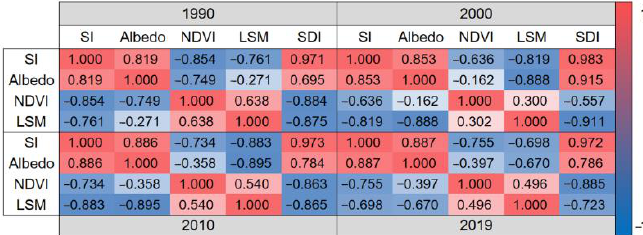
Figure 3. Correlations between pairs of the four selected indicators and their correlations with the SDI in different study years. SI: salinization index; NDVI: normalised difference vegetation index; LSM: land surface soil moisture index; SDI: salinized land degradation index. The blue and red colours represent negative and positive correlations, respectively (the darker the colour, the stronger the correlation).